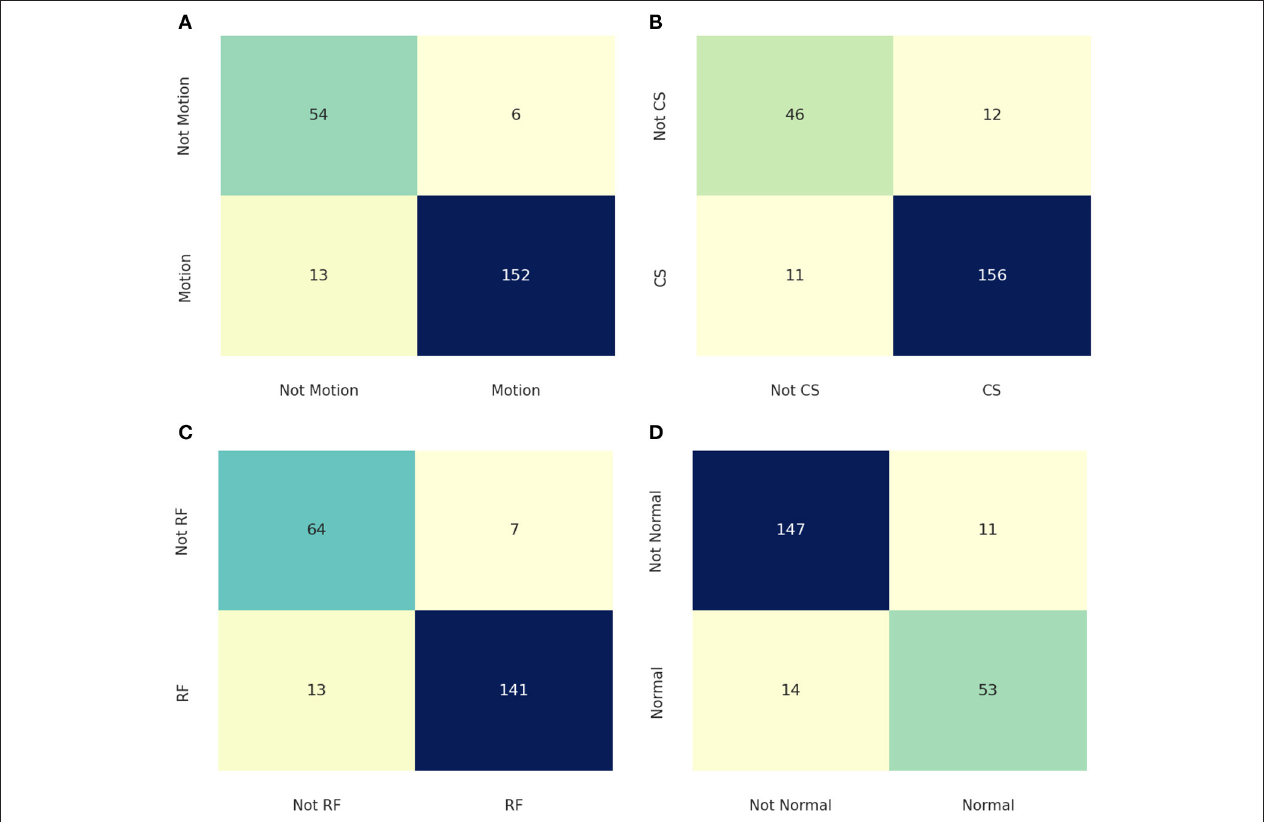
FIGURE 7 | Confusion matrices for the different classes where the ground truth is on the y-axis, and the prediction is on the x-axis. (A) is the confusion matrix for the “Motion” class. (B) shows the confusion matrix for the “Chemical Shift” class. (C) displays the confusion matrix for the “Radio-Frequency” Class. (D) illustrates the confusion matrix for the “Normal”